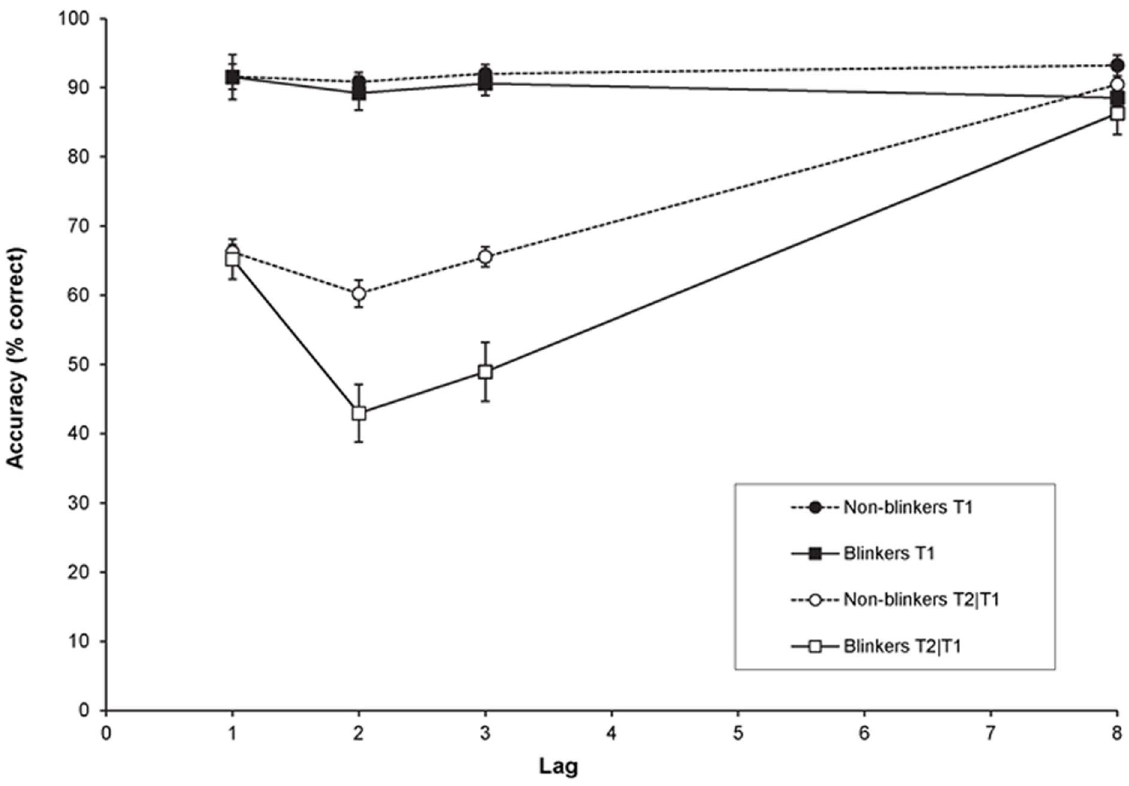
Figure 1. Target accuracy in Experiment 1a. Mean percentage correct report of T1 (black symbols) and T2 given correct report of T1 (white symbols) as a function of lag, for non-blinkers (circles) and blinkers (squares). Error bars reflect standard error of the mean.